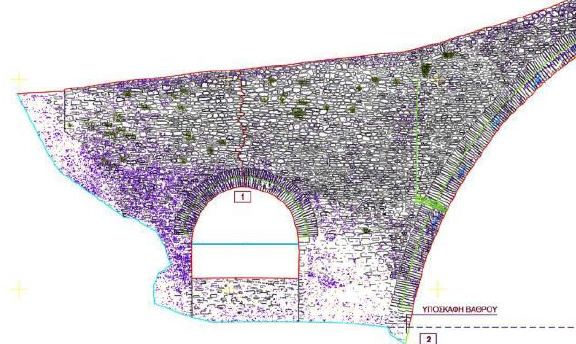
Figure 8. Pathology elevation plan of the South Façade before the collapse.